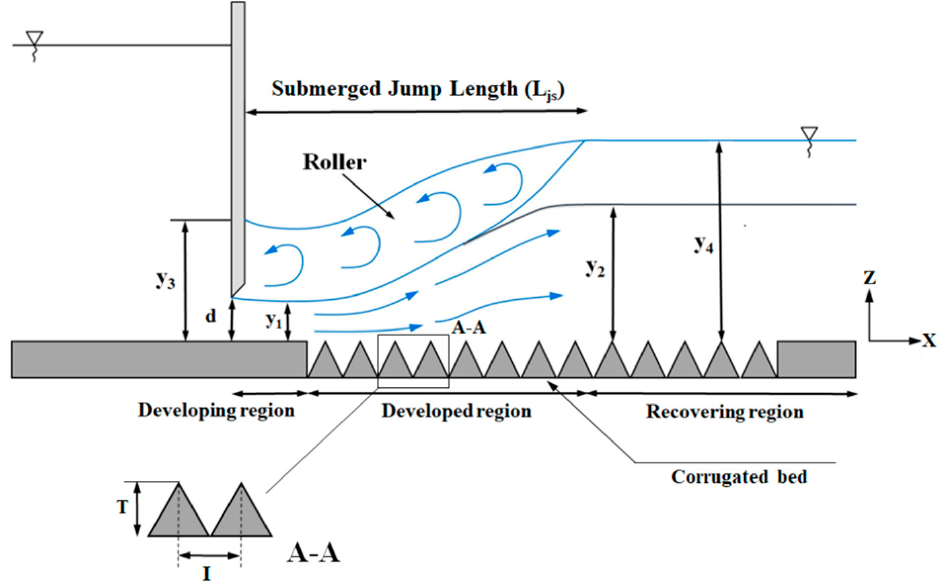
Figure 1. Definition sketch of a submerged hydraulic jump at triangular macroroughnesses.